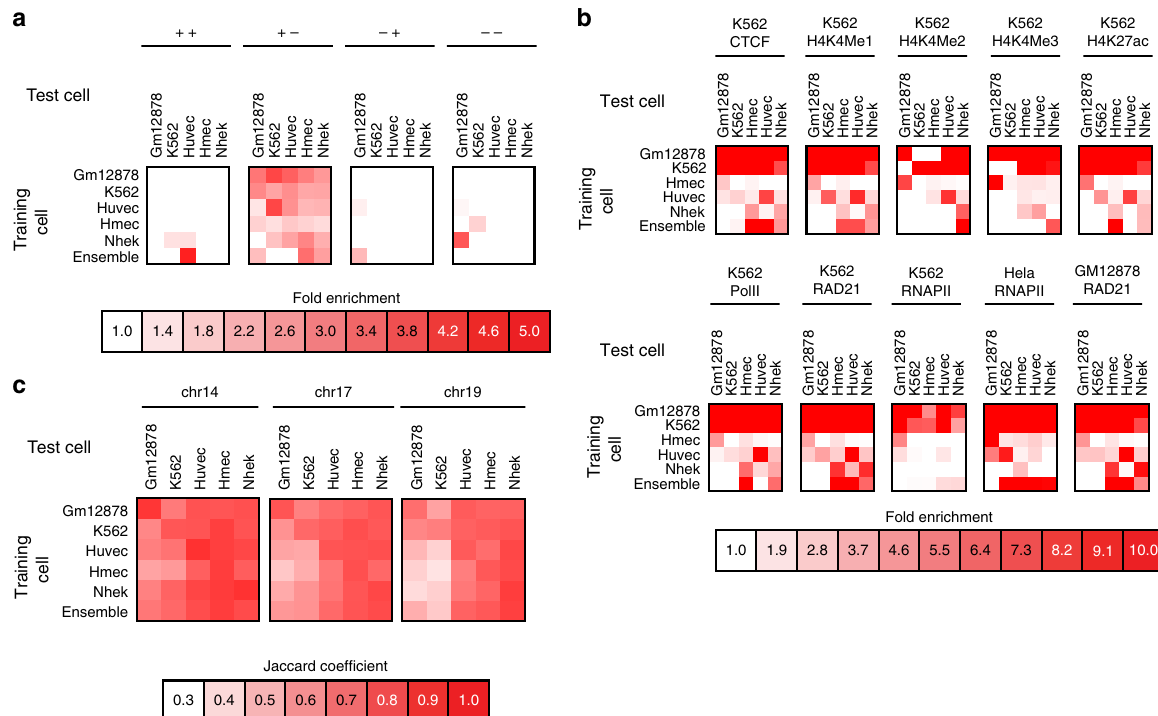
Fig. 7 Ability of HiC-Reg to capture signi fi cant interactions and TADs in new cell lines. a Enrichment of CTCF motifs in four con fi gurations for cross-cell predictions. Shown are the fold enrichments when testing using a model trained on a different cell line or an ensemble of models using MULTI-CELL features. The diagonal entries correspond to the fold enrichment obtained in the cross-validation setting. b Fold enrichment of ChIA-PET interactions in predicted interactions when training on a different cell line, as well as when using the MULTI-CELL ensemble. c Jaccard coef fi cient-based similarity of TADs called on true and predicted interaction counts when training on a different cell line. Shown are Jaccard similarity values for three chromosomes, 14, 17, and 19. Source data are provided as a Source Data fi